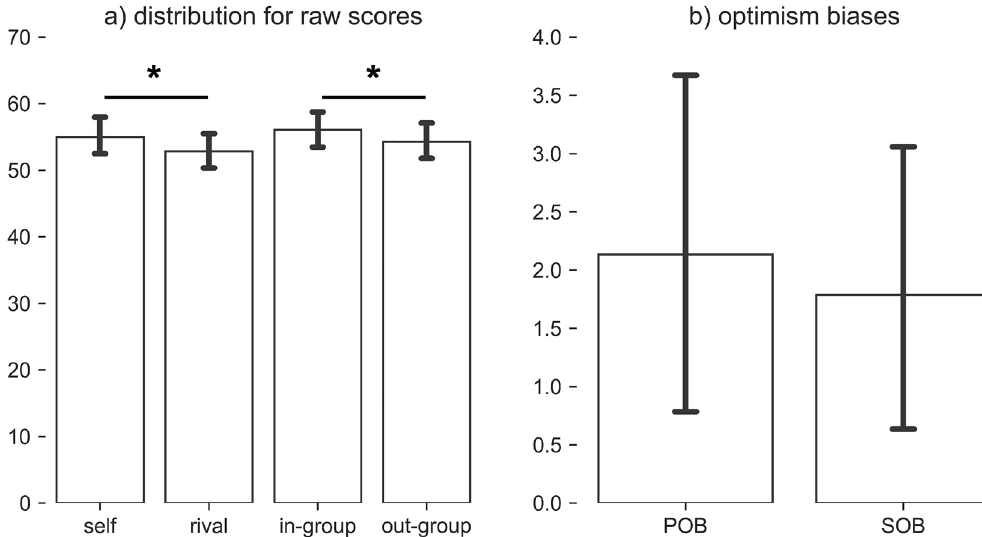
Figure 2. Behavioral data. ( a ) Behavioral data for the raw scores (self, rival, in-group, and out-group) and ( b ) the derived measures (POB, SOB) are presented. * Indicates a significant difference in the means ( p < 0.05). Derived measures are POB = self—rival, and SOB = in-group—out-group, where POB stands for personal optimism bias and SOB for social optimism bias. Both POB and SOB are referred to as targets in the machine learning framework. Error bars represent standard errors.